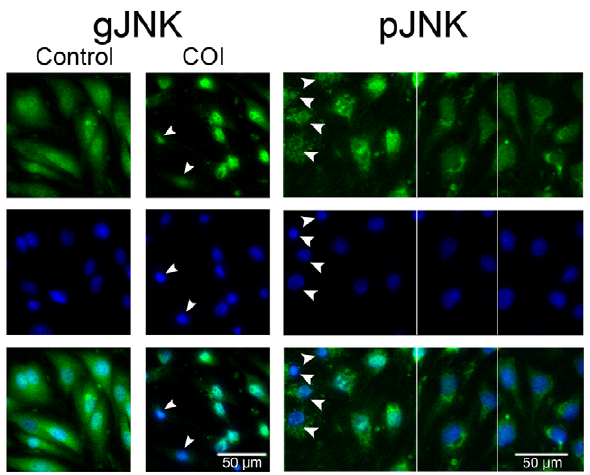
Figure 7. JNK activation and nuclear translocation in bystander cells. bEnd.3 monolayers, were subjected to COI or left untreated and returned into the incubator for 3 more h, then fixed with 4% PFA and stained for gJNK or pJNK (pseudo-colored green) as indicated. After immune-staining, the cell nuclei were counter stained by DAPI (pseudo- colored blue) and imaged by fluorescence microscope. gJNK: Untreated cells exhibit JNK distribution throughout the cell. In treated monolayers, bystander cells adjacent to PI + cells (marked by arrowheads, 60–80 m m away from rim of the COI) show distinct JNK nuclear localization. pJNK: a collage comprised of three snapshots separated by vertical white lines. Bystander cells adjacent to PI + cells show pJNK in the nucleus (left side) while distant cells have no pJNK staining (right side). Lowest panels are a merge of the upper ones. doi:10.1371/journal.pone.0041633.g007 internalization of acetylated LDL and adhesion molecule expres- sion, upon stimulation with pro-inflammatory cytokines [67]. The relevance of this cell line to living endothelium was further established in our lab, by demonstrating the ability of bEnd.3 cells to form 3D capillary tubes on basement membrane matrix (Fig. S2); this requires unique expression and arrangement of multiple adhesion and adherence molecules [68]. On this basis, bEnd.3 cells appear to represent an authentic model for examination of gap junction communication among endothelial